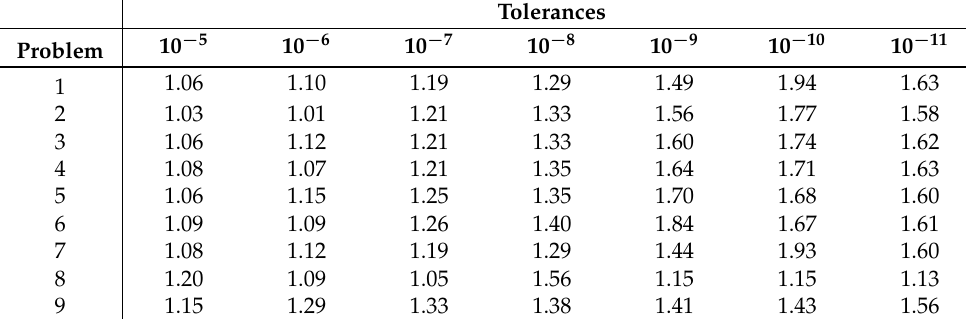
Table 3. Efficiency measures ratios of PTP6(5) vs.